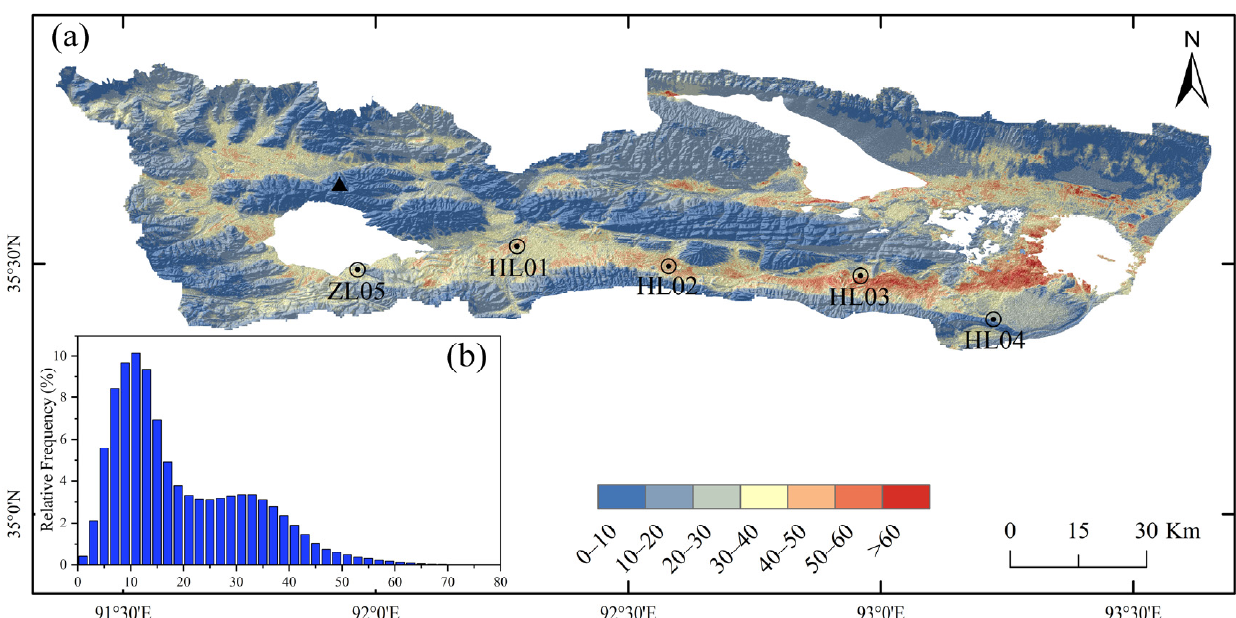
Figure 6. The spatial distribution ( a ) and statistical characteristics ( b ) of seasonal deformation (the time-series deformation of the boreholes is shown in Figures 3 and 5).